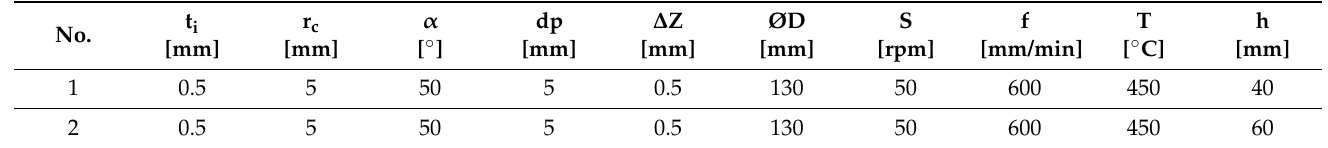
Figure 3. The shape CAD of the truncated cone used to create a punch toolpath.